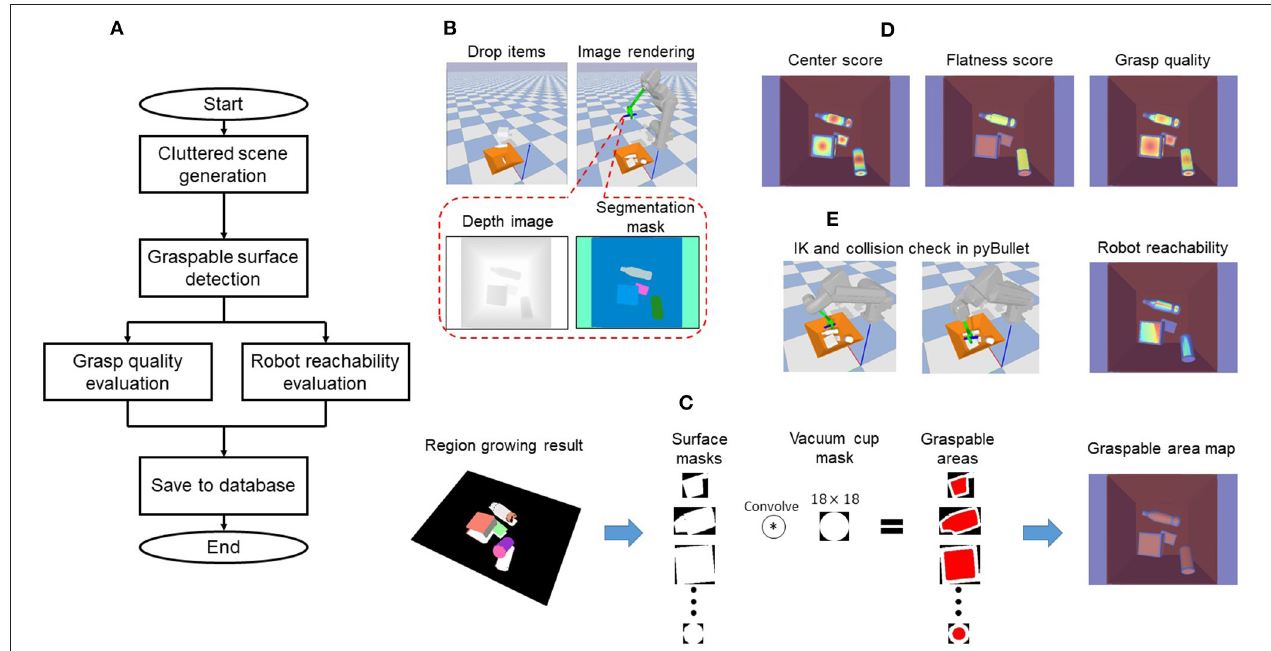
FIGURE 3 | Data generation pipeline: (A) Dataset generation flow; (B) Cluttered scene generation; (C) Graspable surface detection; (D) Grasp quality evaluation; (E) Robot reachability